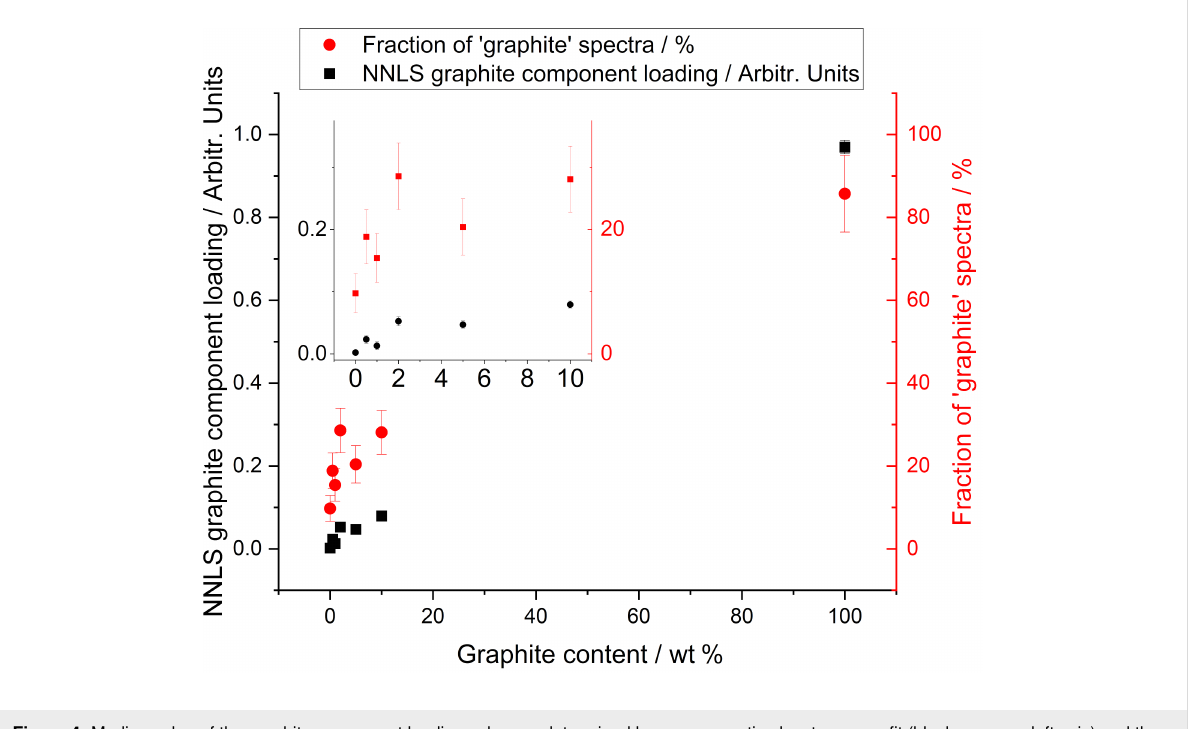
Figure 4: Median value of the graphite component loading value, as determined by a non-negative least-squares fit (black squares, left axis) and the fraction of points that show a graphite-like spectrum (red squares, right axis). A graphite-like spectrum is defined as having a correlation value to the graphite spectrum of greater than 0.15, as obtained from a non-negative linear least-squares procedure when fitted with both a GNP and graphite spectrum. The inset shows the low-loading region of the graph, with the same